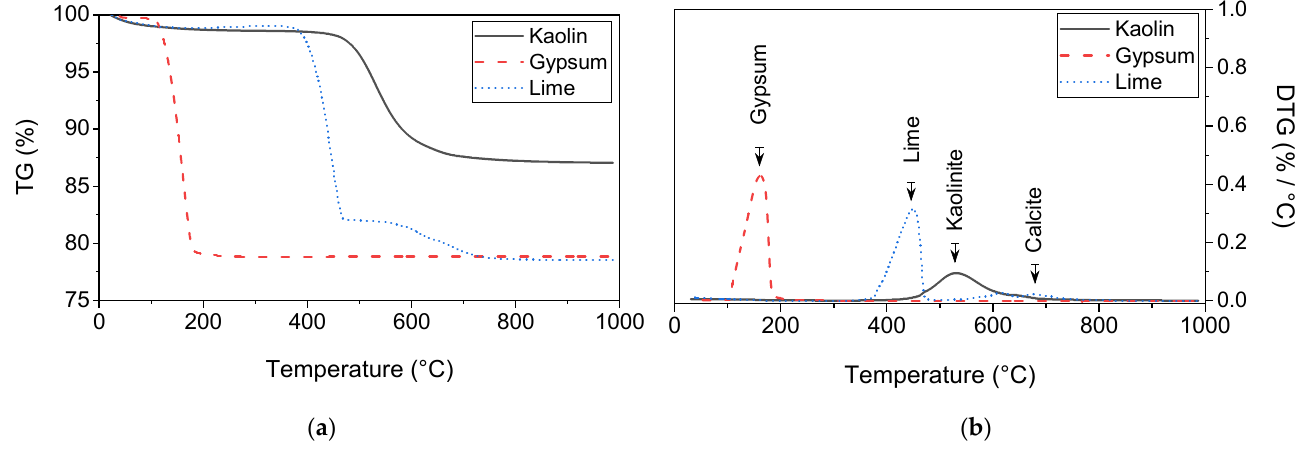
Figure 2. Thermogravimetric and derivative thermogravimetric (TG/DTG) curves of kaolin, lime, and gypsum: ( a ) TG and ( b ) DTG.